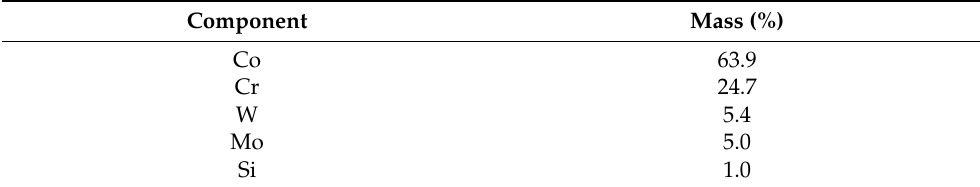
Table 2. Chemical composition of Mediloy S-Co Cobalt Chromium